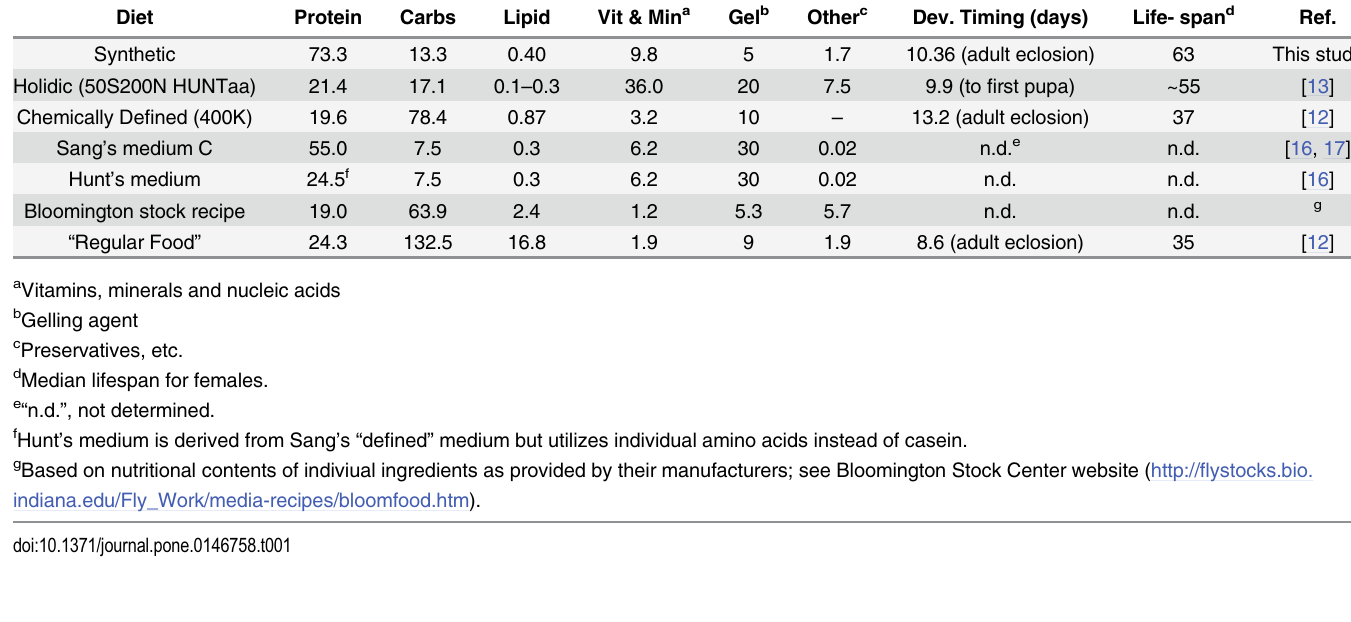
Table 1. Concentrations (in g/L) of relevant components of various Drosophila media and relevant indicators of dietary effects on development, fecundity/fertility, and longevity. Diet Protein Carbs Lipid